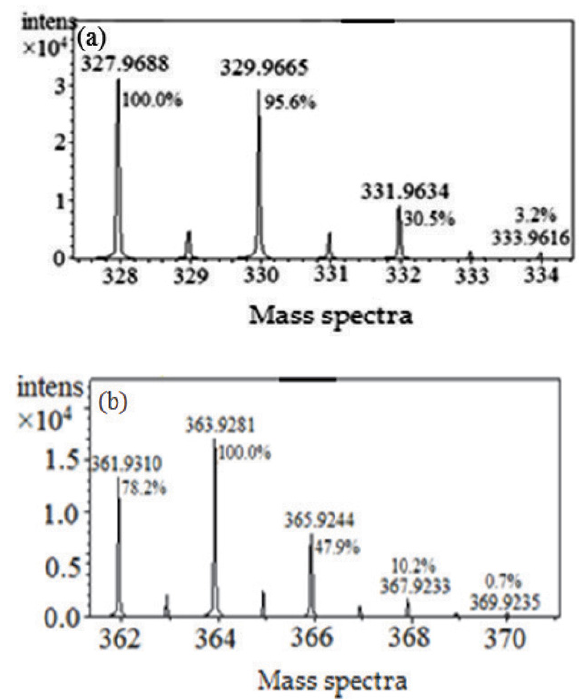
Figure 5. Mass spectra profile using LC-TOF/MS for simvastatin chlorinated by-products (a): three chlorine atoms and (b) four chlo- rine